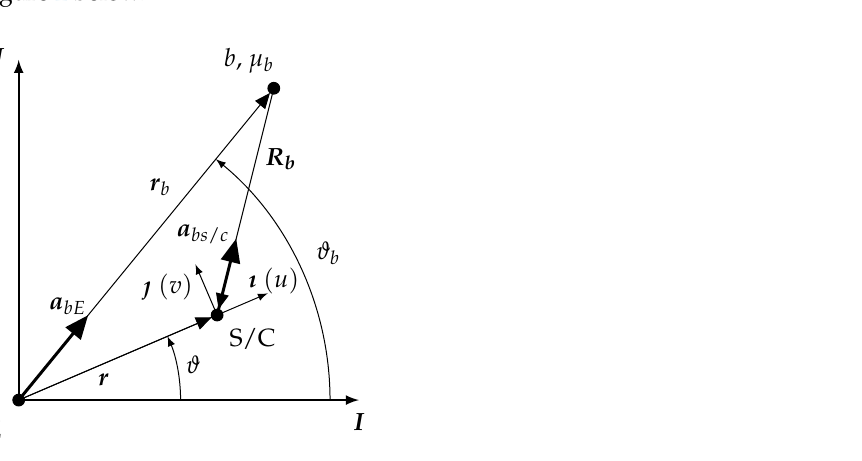
Figure 2. Schematic representation of gravitational perturbation in EME2000